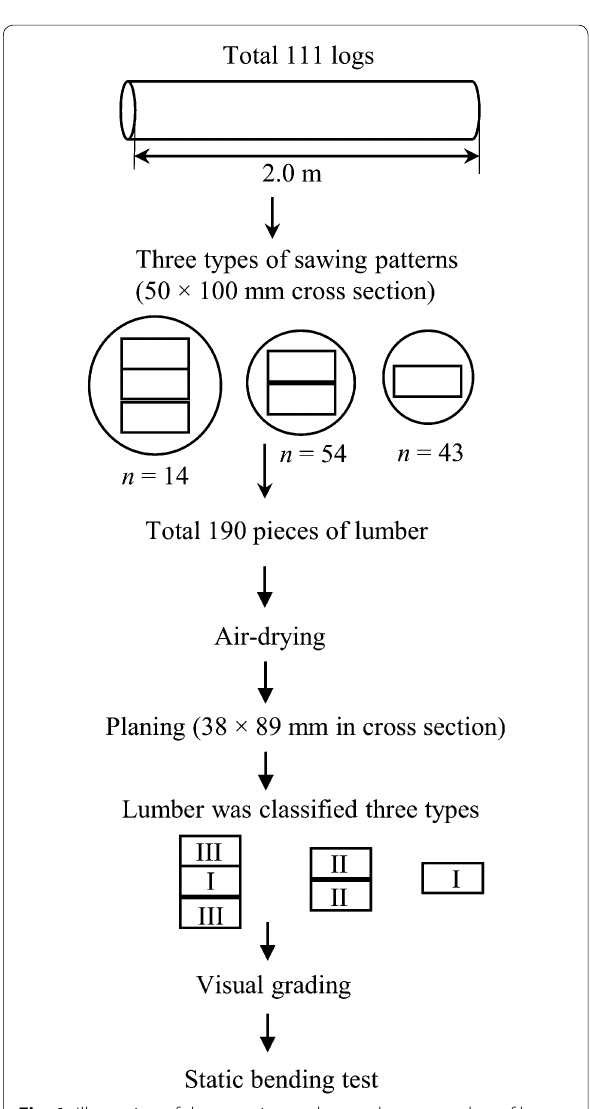
Fig. 1 Illustration of the experimental procedure. n number of logs. Among the large diameter logs, four lumber (one lumber was type I, and three pieces of lumber were type III) were obtained from one log. Totally, 194 pieces of lumber were obtained from 111 logs. However, we failed to collect the data of bending tests for four pieces of lumber. Thus, totally 190 pieces lumber data were